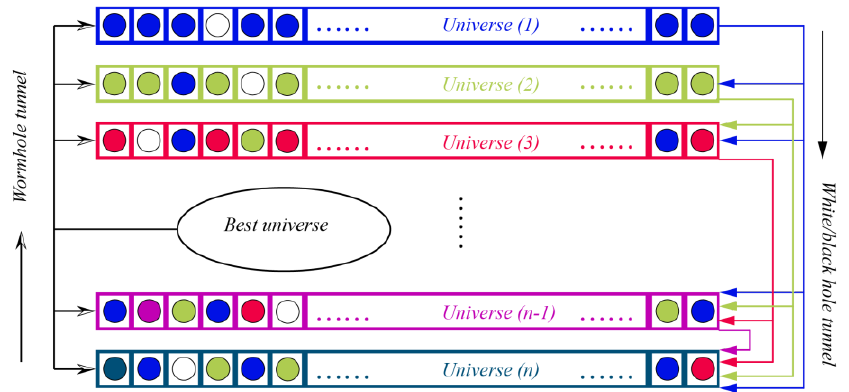
Figure 2. The conceptual model of wormholes in the MVO algorithm.